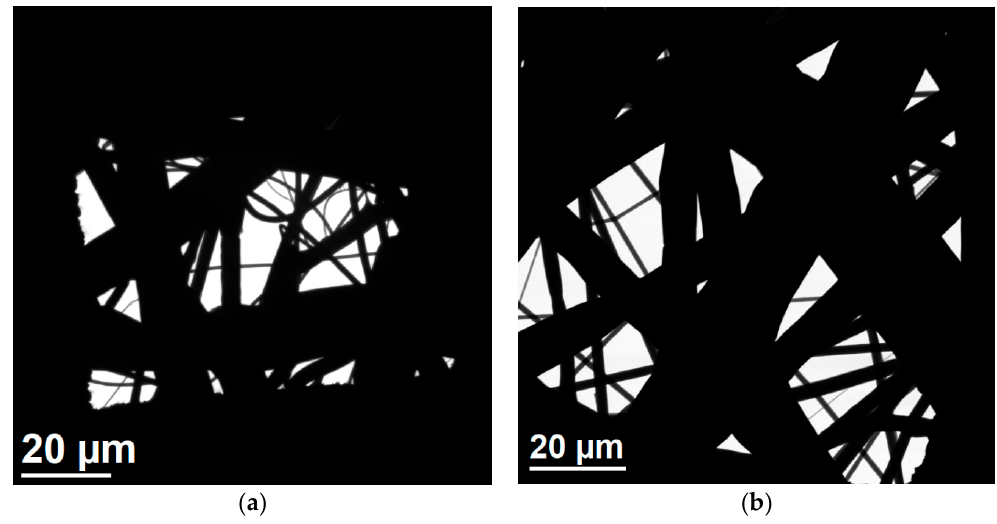
Figure 12. TEM images of the internal layer of the filter before (a) and after (b) sterilization.